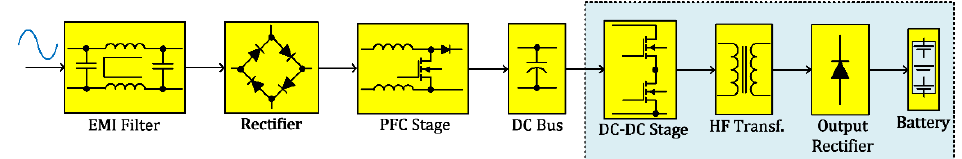
Figure 2. Block diagram for a typical EV UFC.